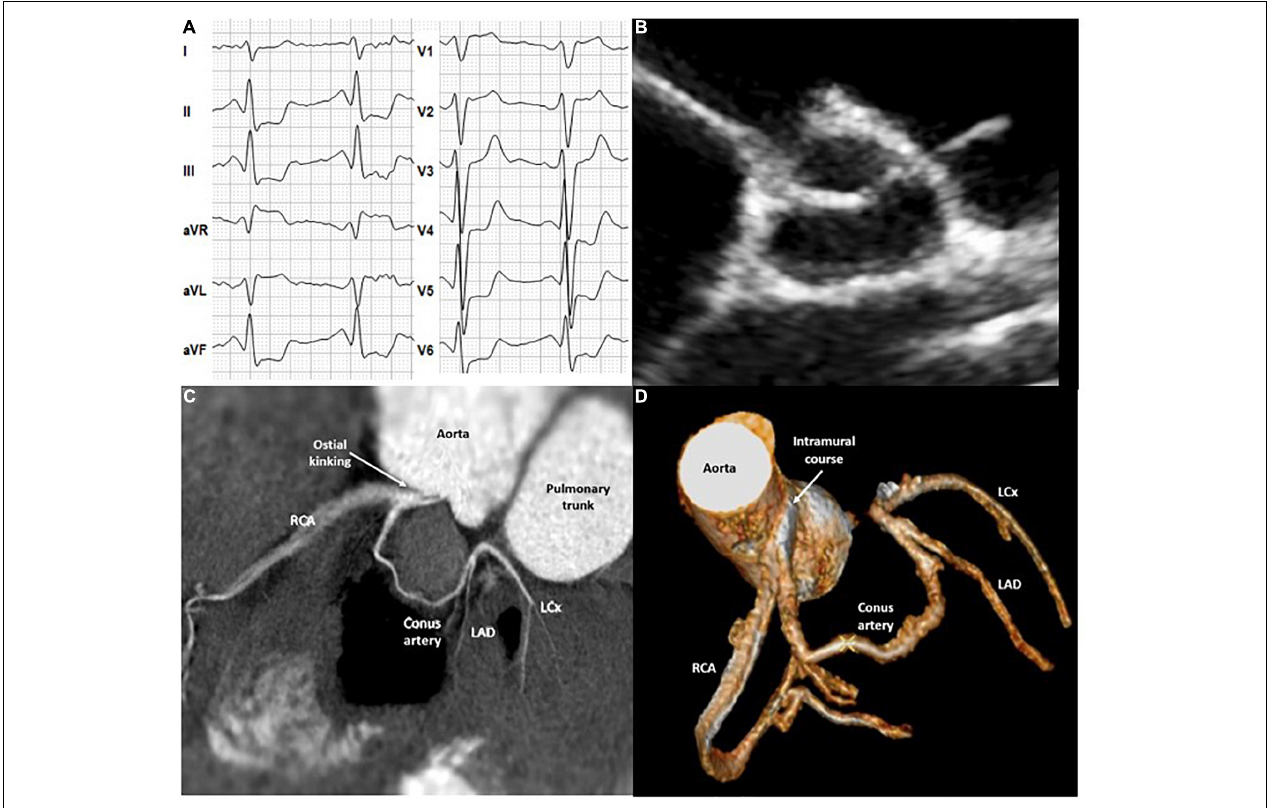
FIGURE 1 | (A) Exercise electrocardiogram. (B) Transthoracic echocardiography. (C,D) Coronary computed tomography angiography. LCx, Left circumflex artery; LAD, Left anterior descending artery; RCA, Right coronary